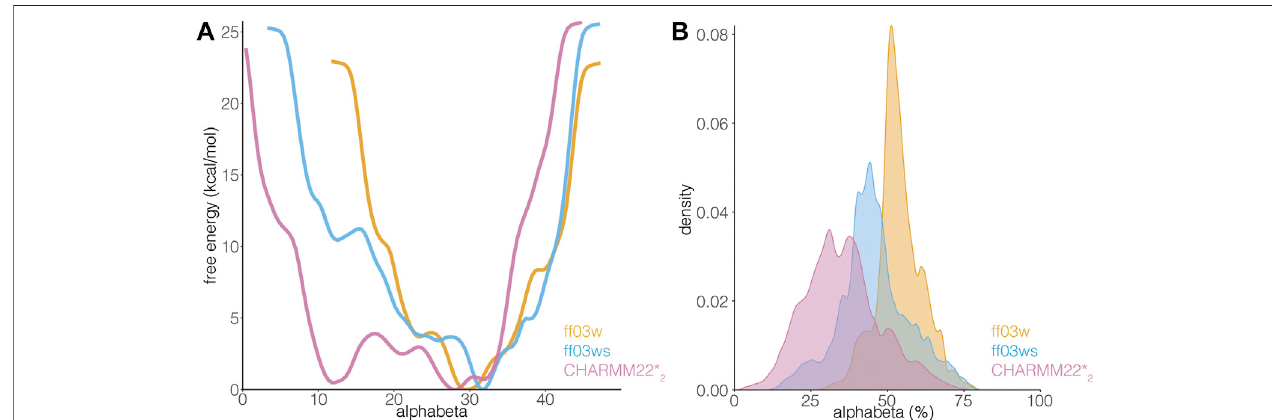
FIGURE 4 | AT-3 306-361 is characterized by a disordered ensemble with a low structural propensity and heterogeneous helical states. (A) The plot shows the one- dimensional free energy pro fi le associated with the collective variable alphabeta for the ff03w (orange), ff03ws (blue), and CHARMM22* 2 (pink) metadynamics simulations. (B) The plot shows the distribution of alphabeta values expressed as a percentage, i.e., alphabeta values divided by the total number of torsional angles considered. Ff03w and ff03ws show overstabilization ofhelical conformations while CHARMM22* 2 better describes the disordered ensemble of AT-3 306-361 in the free